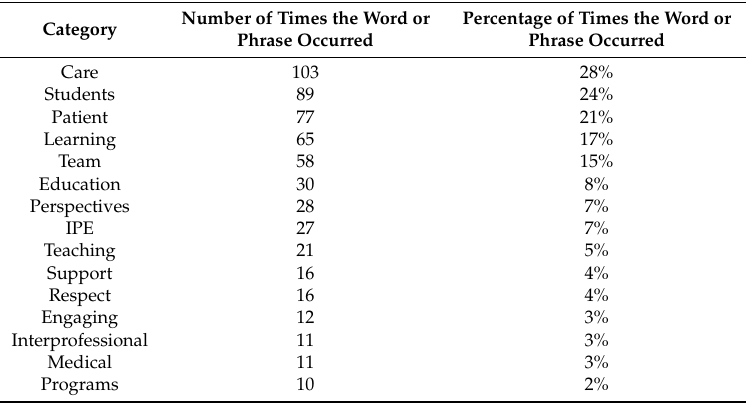
Table 1. Positive factor category